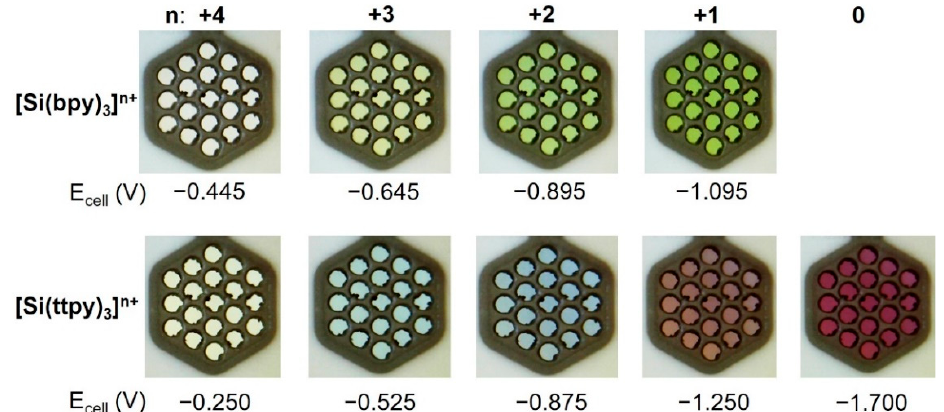
Figure 2. UV-vis spectra recorded at regular intervals from − 250 to − 525 mV ( top ), − 525 to − 875 ( second ), − 875 to − 1250 ( third ), and − 1250 to − 1700 mV ( bottom ).